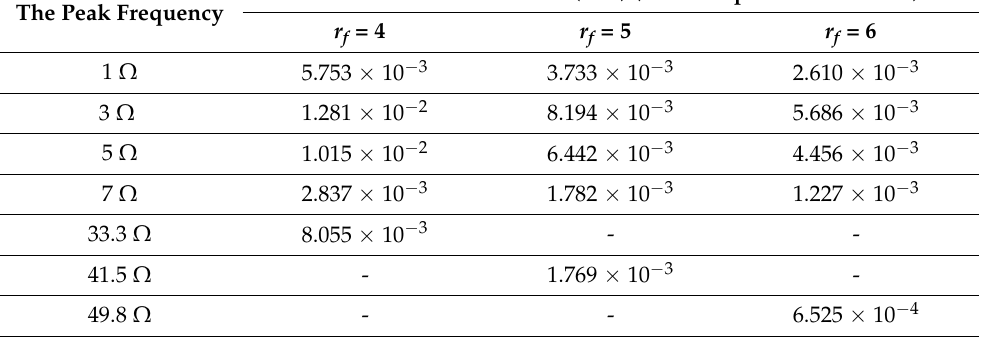
Table 6. The peak amplitude of the lateral vibration spectrum of the follower output node D where Ω = 320 rad/s and with three follower rod radii.